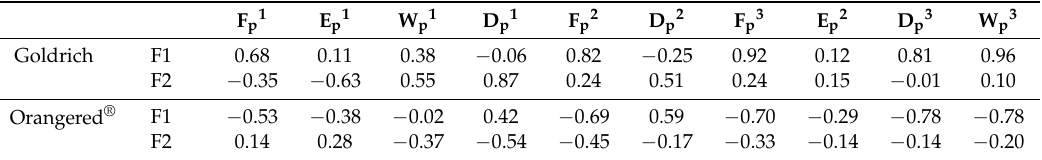
Table 5. Correlation coefficients ( p ≤ 0.05) between discriminant scores (F1 and F2) and texture parameters extracted from the force/deformation curves.